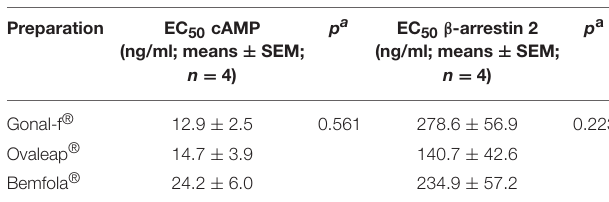
TABLE 5 | Efficiency (EC 50 ) of 30 min-cAMP and β -arrestin 2 production induced by reference and biosimilar follitropin alfa preparations in transfected, FSHR-expressing HEK293